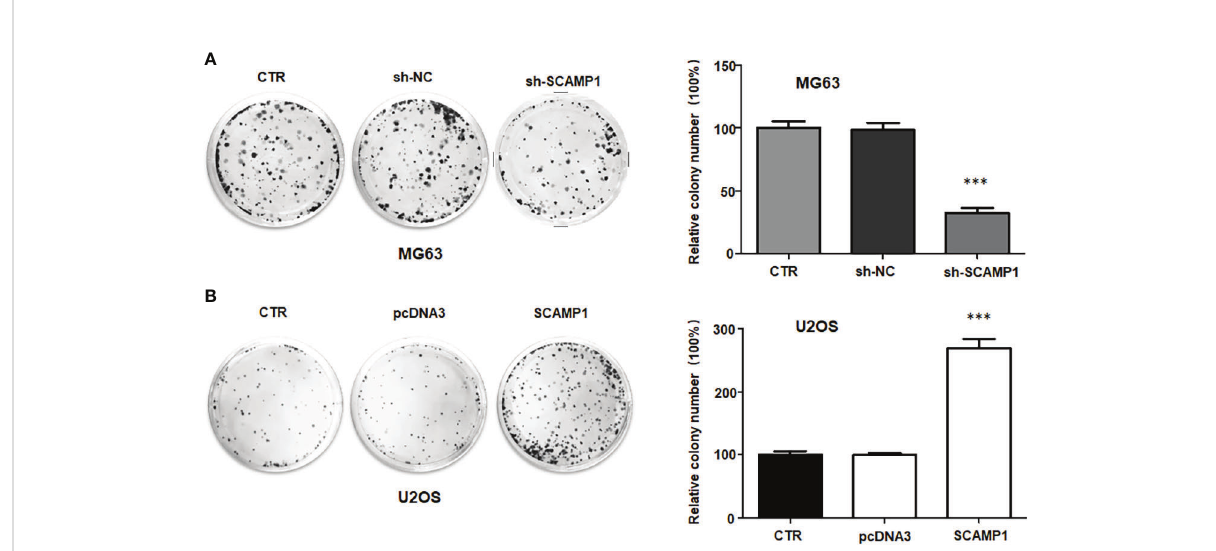
FIGURE 2 LncRNA SCAMP1 overexpression increases colony formation of osteosarcoma cells. (A) : Left panel: Colony formation assays showed that sh-SCAMP1 transfection reduced colony formation of MG63 cells. Right panel: quantitative data is shown for colony formation of MG63 cells. (B) : Left panel: Colony formation assays showed that SCAMP1 cDNA transfection increased colony formation of U2OS cells. Right panel: quantitative data is shown for colony formation of U2OS cells. ***p<0.001 vs. control group.